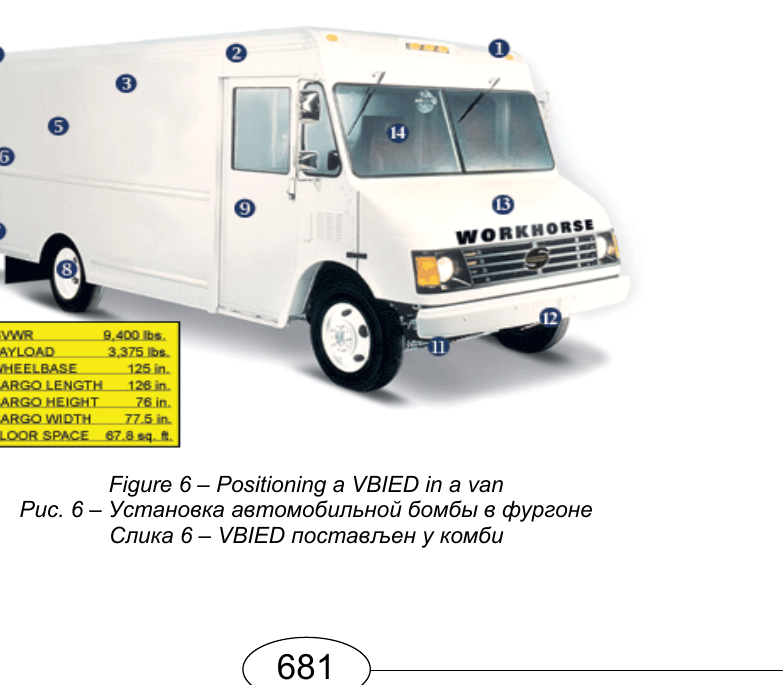
Figure 6 – Positioning a VBIED in a van Рис . 6 – Установка автомобильной бомбы в фургоне Слика 6 – VBIED постављен у